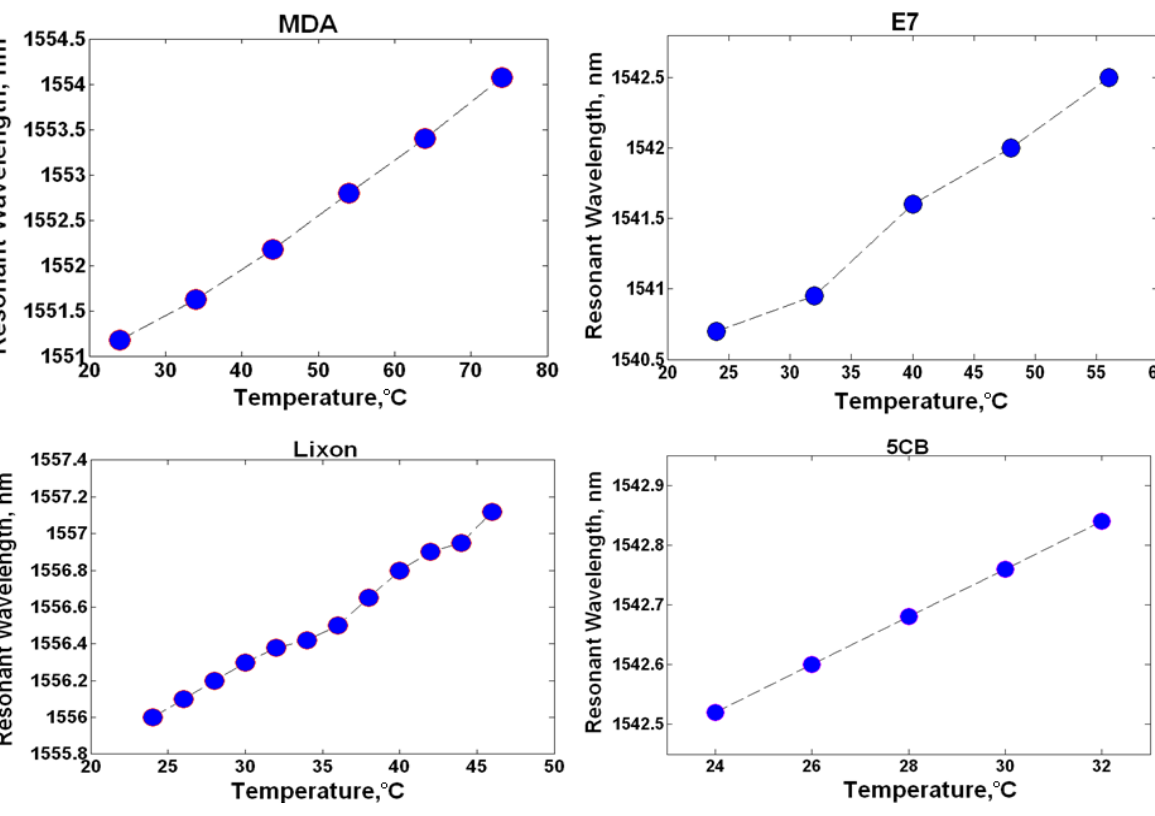
Figure 2. Measured ring resonator samples clad in liquid crystal (LC)